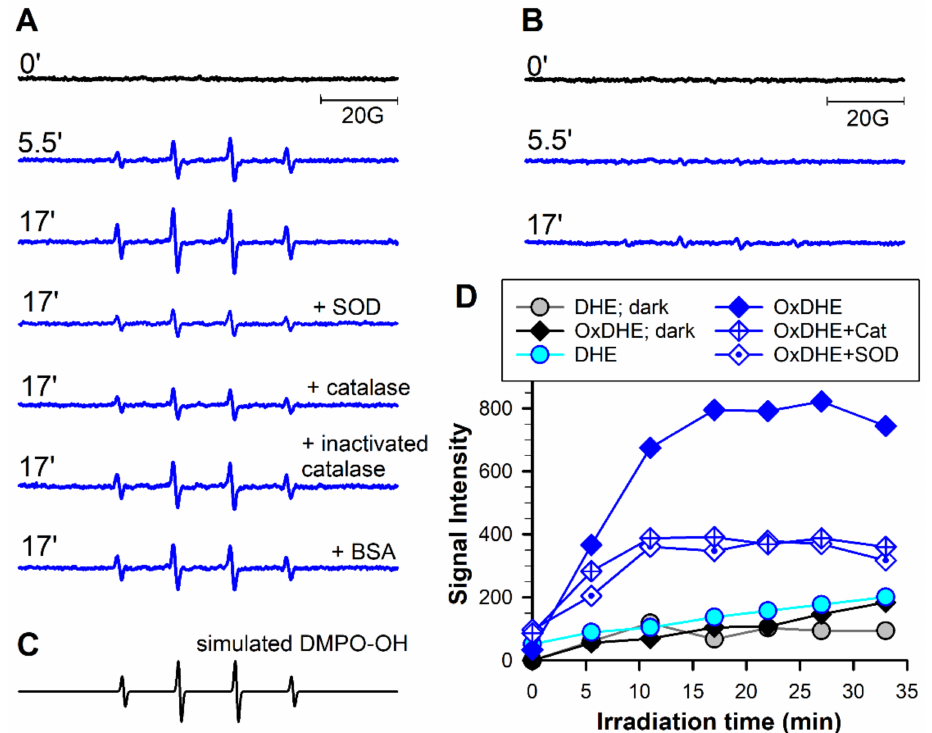
Figure 7. Photoexcitation of OxDHE liposomes with visible light in the presence of 5,5-dimethyl-1-pyrroline N-oxide (DMPO) as the spin trap DMPO results in superoxide dismutase (SOD)- and catalase-dependent accumulation of DMPO- • OH adducts. ( A , B ): Representative electron spin resonance (ESR) spectra acquired from samples of liposomal suspensions made from oxidised (OxDHE, A ) or freshly opened 16:0-22:6PC (DHE, B ) exposed in the presence of 0.1 DMPO to 27 mW/cm 2 visible light inside the resonant cavity of ESR spectrometer. The spectra were acquired at indicated irradiation times in the absence and presence of 0.1 mg/mL superoxide dismutase (SOD), catalase, catalase inactivated by irradiation with UV light, or bovine serum albumin (BSA). ( C ) a simulated spectrum of DMPO adduct with the hydroxyl radical (DMPO- • OH) allowing for identification of the adduct in the experimental spectra. ( D ) representative kinetics of DMPO- • OH adduct accumulation in the suspension of liposomes made from DHE or OxDHE in the dark (as indicated in the legend) or during irradiation with light (blue and cyan symbols and lines) in the absence and presence of SOD or catalase